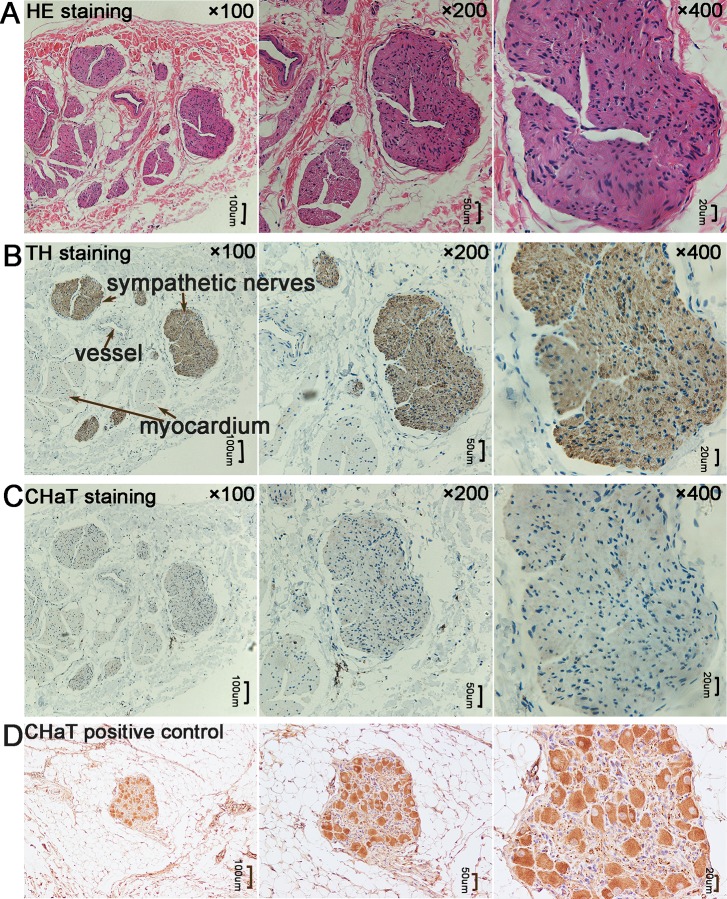
The LOMLSPV contains abundant sympathetic but not parasympathetic nerves.(A) HE staining; (B) positive TH staining; (C) negative CHAT staining; (D) CHAT positive control.